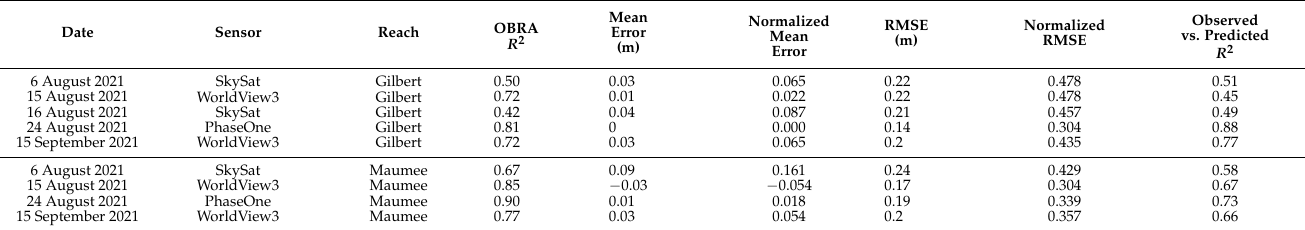
Table 2. Summary of optimal band ratio analysis (OBRA) depth retrieval results for each image used in this study. OBRA R 2 values are based on a calibration subset of the field-based depth measurements and error statistics, and observed vs. predicted regressions are based on a separate subset of the field data set aside for